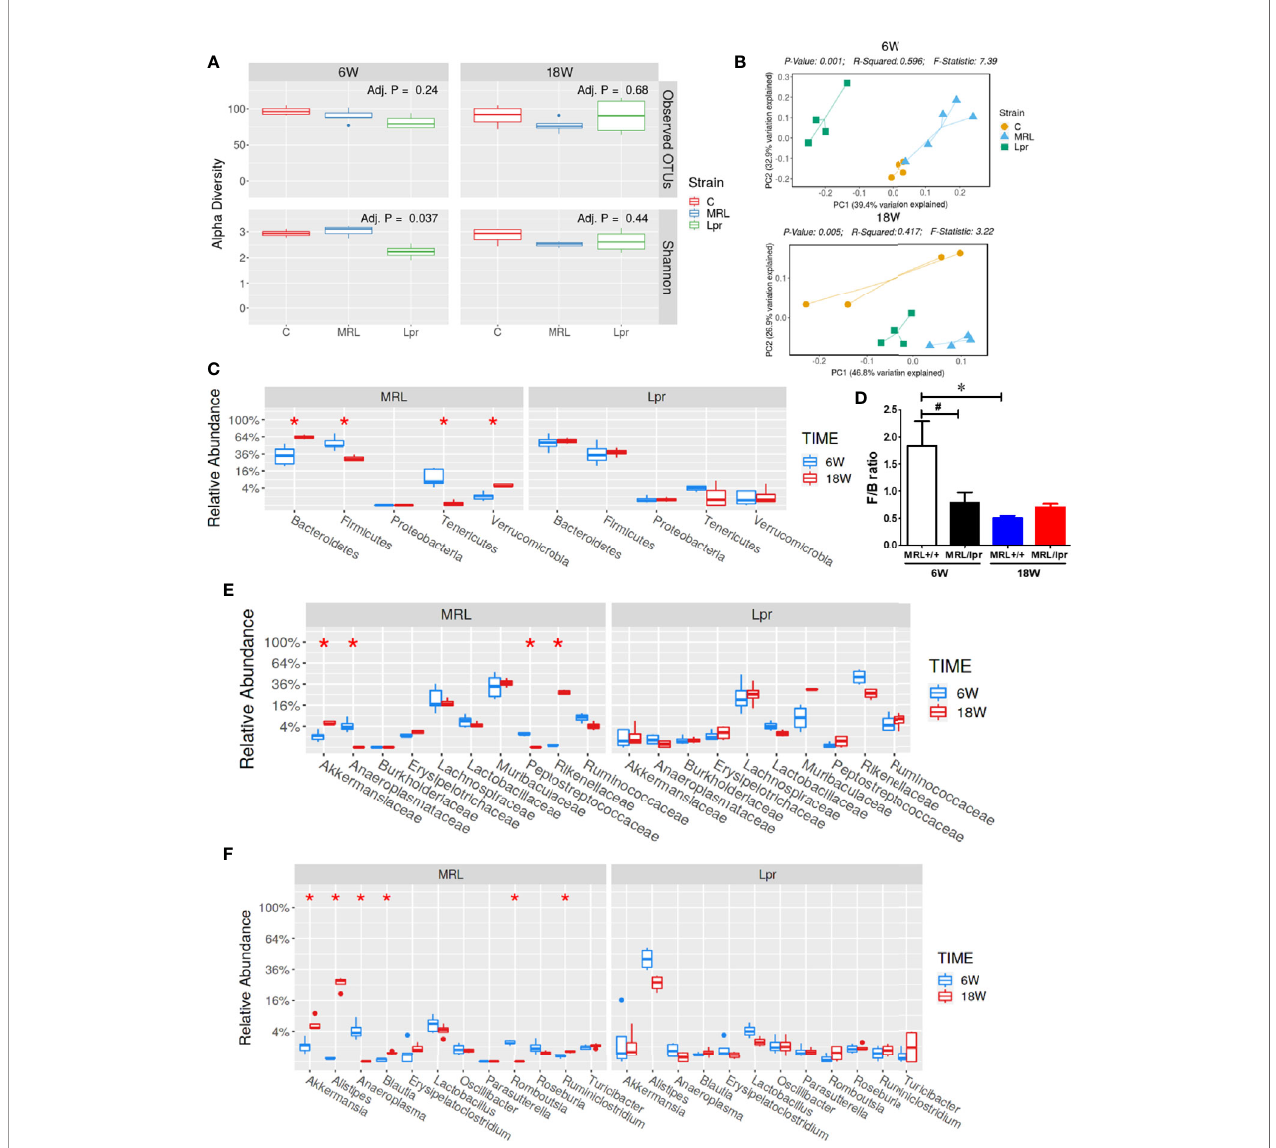
FIGURE 4 | SLE-associated gut microbiome diversity and composition. Fecal pellets from C57BL/6 (C), MRL+/+ (MRL) and MRL/lpr (Lpr) mice were collected and bacterial DNA was isolated and subjected to 16s rDNA sequencing to evaluate the composition of microbiome in each mice. (A) The variety of organisms in a community, termed as alpha diversity. (B) Different mouse strains showed distinct microbiome pattern at 6 week and 18 weeks of age. (C) Age-associated differences in fecal microbiome from MRL+/+ and MRL/lpr mice at phylum level. (D) F/B ratio in MRL+/+ and MRL/lpr mice. (E) Taxa relative abundance at family level in MRL+/+ and MRL/lpr mice. (F) Taxa relative abundance at genus level in MRL+/+ and MRL/lpr mice. Results are mean ± SEM. n = 4 * p < 0.05; # p <